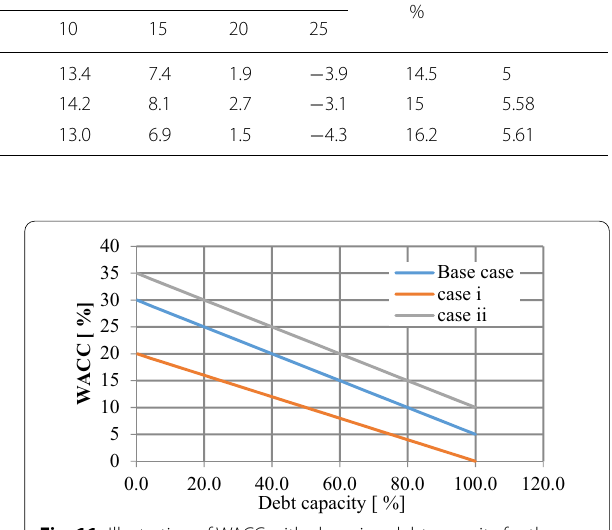
Fig. 11 Illustration of WACC with changing debt capacity for three different debt-to-equity